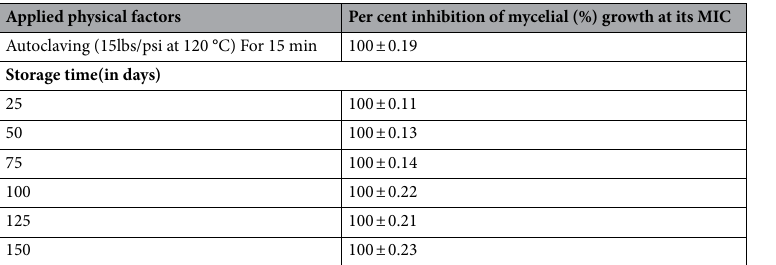
Table 5. Effect of physical factors on the fungi toxicity of mixture oil (Lavang and sowa leaf oil). SD standard deviation. *Values given are mean of three replicates.